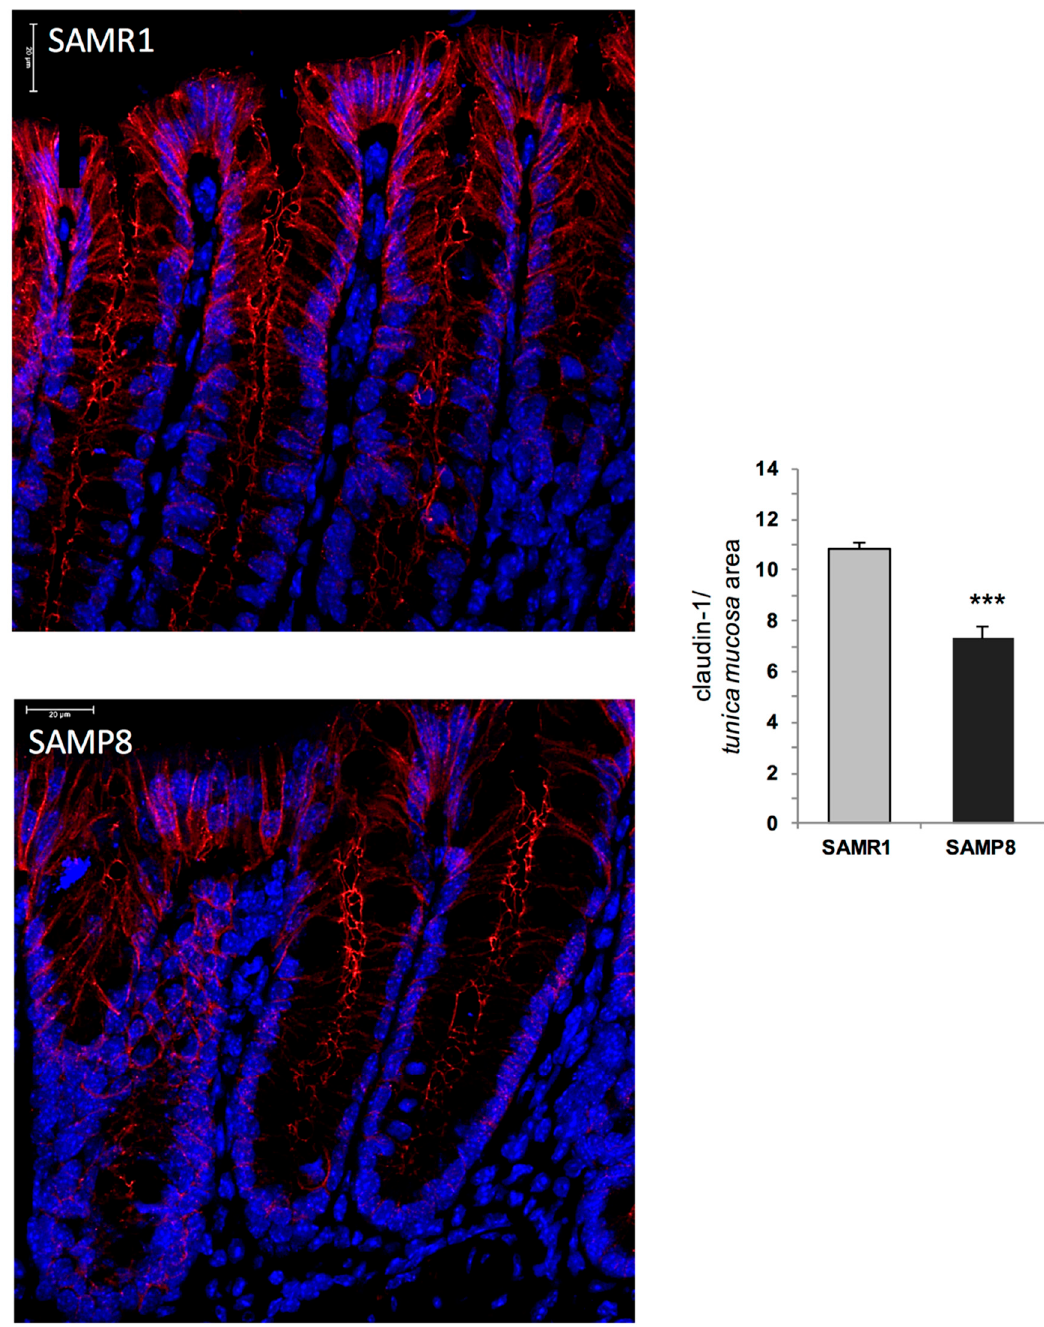
Figure 6. Representative photomicrographs of claudin-1 immunostaining in the cross-sectioned colon from SAMR1 and SAMP8 mice at six months of age. Original magnification 63 × . The column graph displays the mean values of the percentage of positive pixels (PPP) within the respective tissue area examined ± S.E.M from eight animals. Scale bar 20 µ m *** p < 0.001. Statistics: Student’s t -test (for unpaired data).